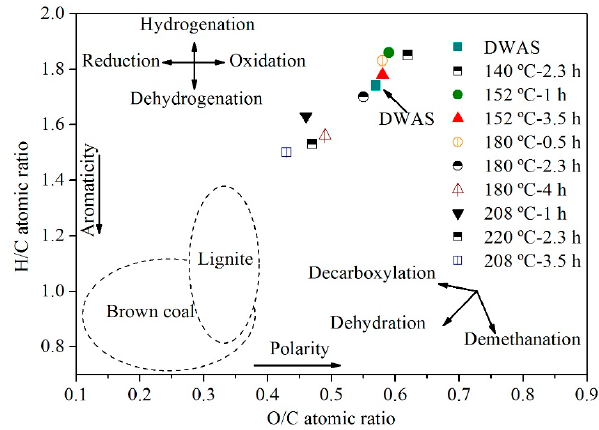
Figure 1. Van Krevelen diagram of DWAS and of carbon materials obtained at di ff erent temperatures and reaction times. and reaction times.